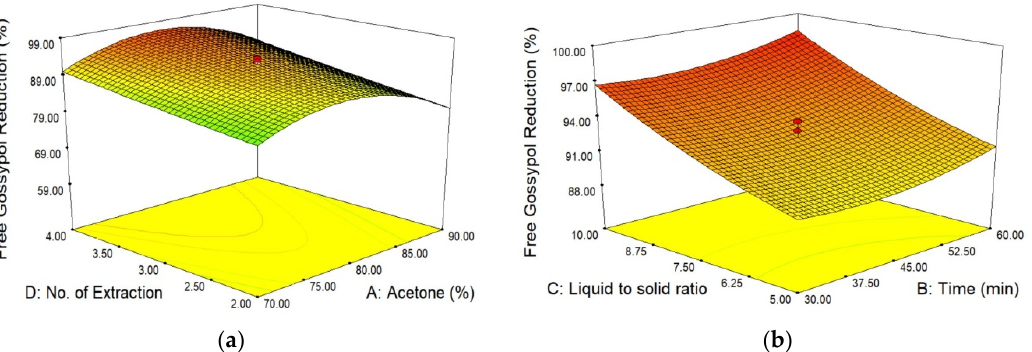
Figure 6. ( a ) 3D surface plot between no. of extraction cycles and acetone % ( b ) 3D surface plot between LSR and time of extraction.